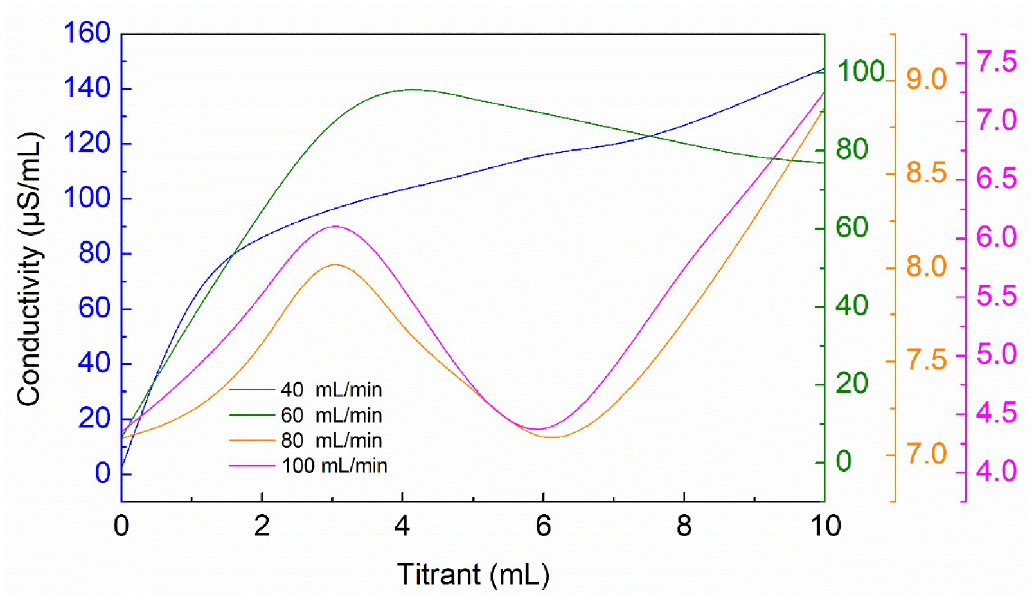
Fig 8. Influence of nitrogen-gas flow rates on conductivity